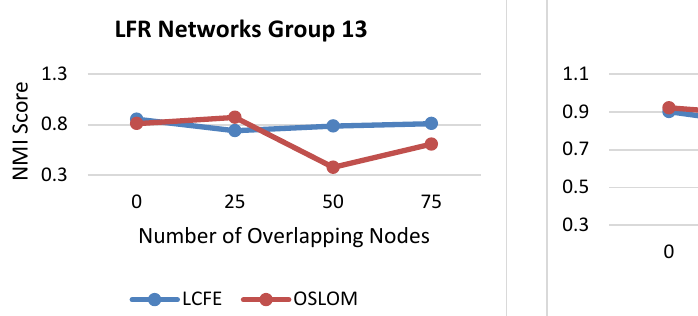
Fig. 16. NMI score comparison for LCFE and OSLOM for fourteenth group of LFR Networks with number of overlapping nodes ranging from 0 to